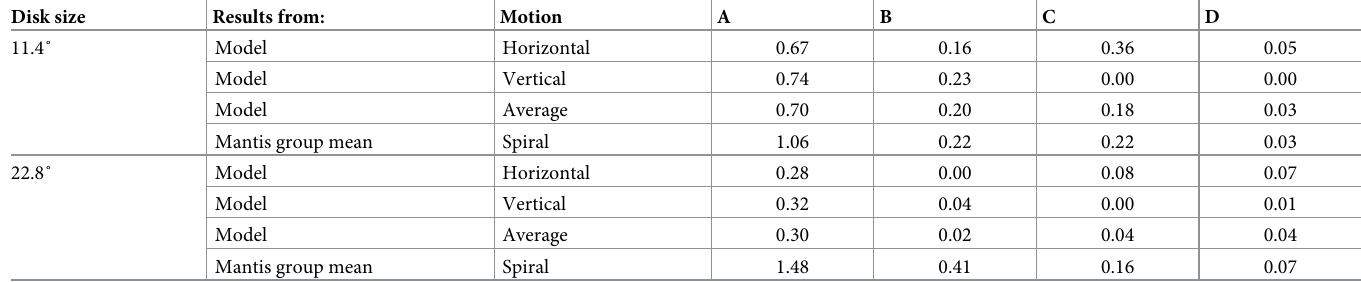
Table 4. Mantids are not fooled by ghost matches. Mean number of strikes predicted by the model, and observed in mantids, for the four stimulus geometries shown in Fig 10A–10D. Disk size Results